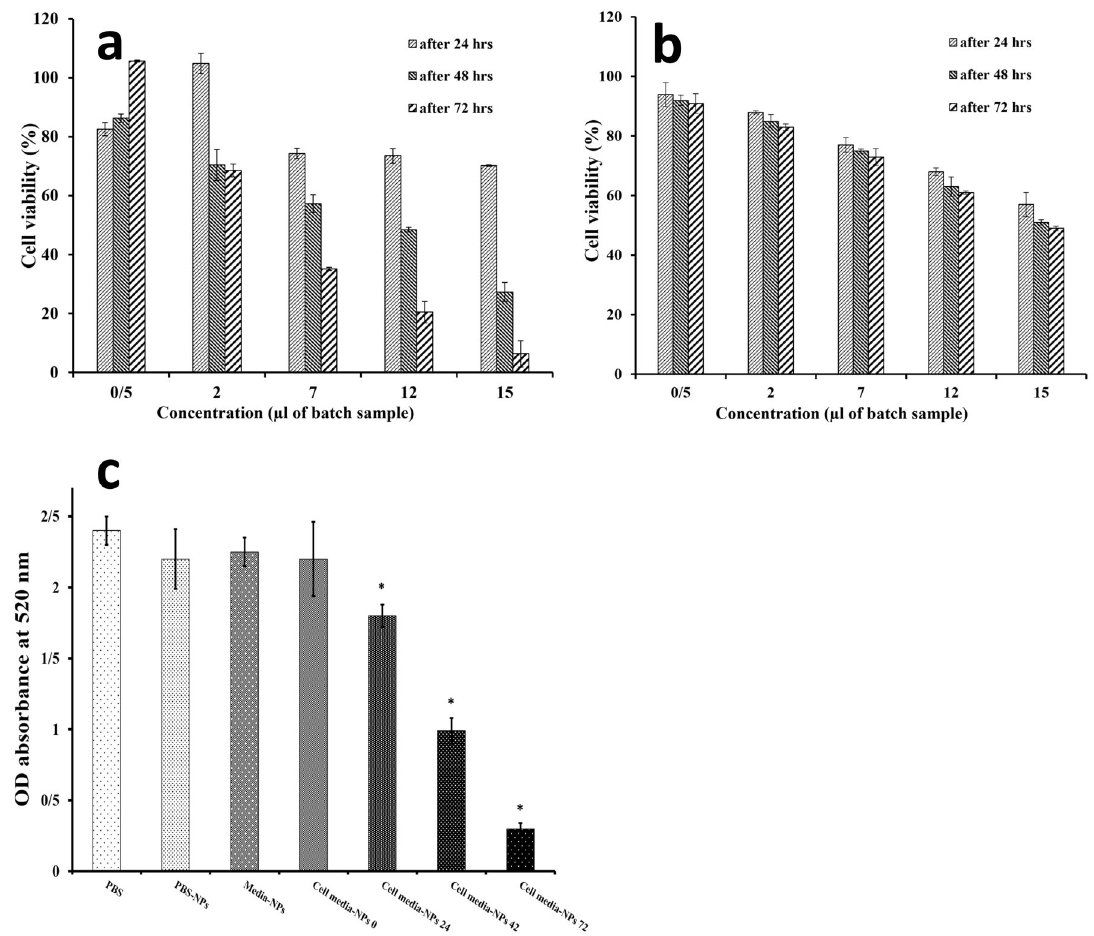
Fig. 5 MTT analysis chart of the cells after the treatment with a serial dilution of the batch curcumin niosome nanoparticles on sw-1736 thyroid cancer cells ( a ) and normal Hu02 cell line ( b ). The IC50 points of the nanoparticles were 7 and 15 µl for sw-1736 thyroid cancer cells and normal Hu02 cell line respectively. DPPH assay before and after